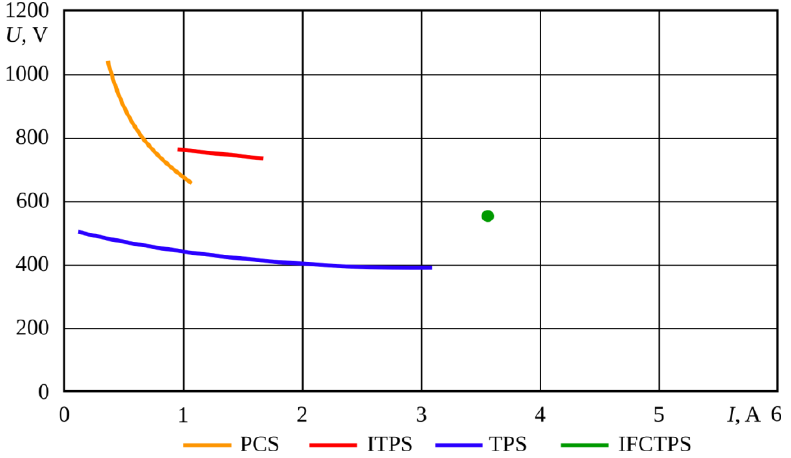
Figure 15. Control characteristics of the tested power supplies loaded with plasma reactor, plasma gas: air, volumetric flow rate: 1.6 m 3 /h.